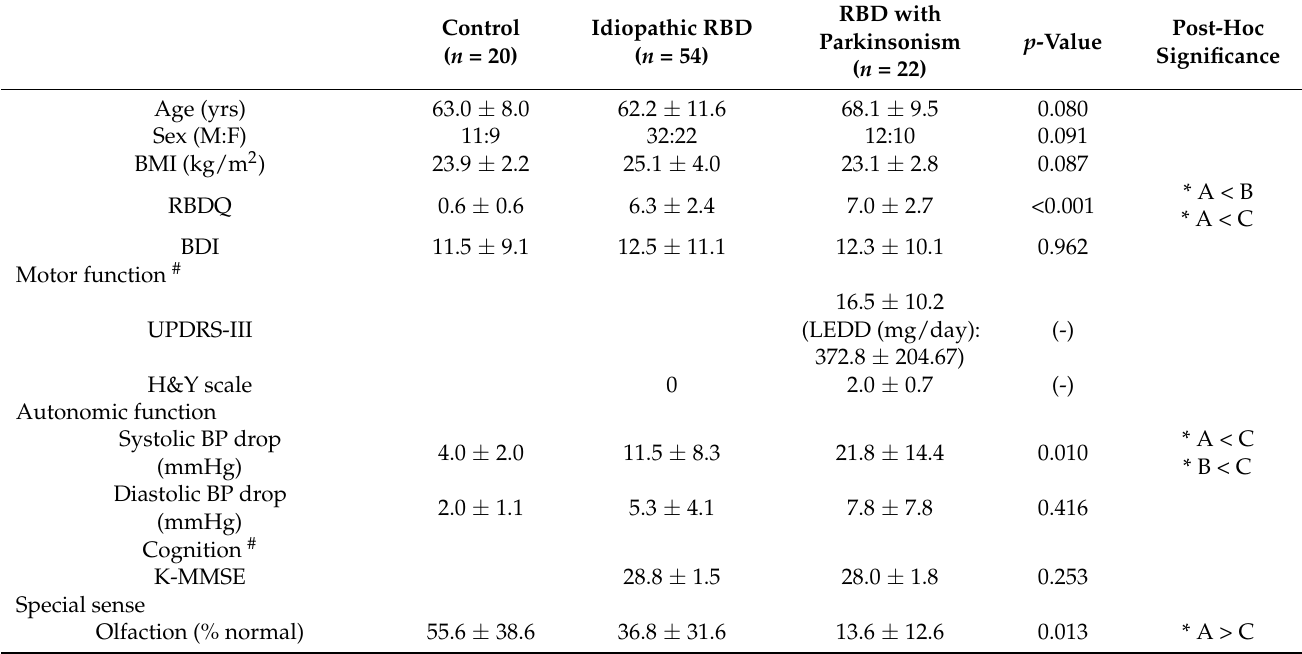
Table 1. Demographic findings and clinical features in control, patient groups with idiopathic RBD and patients with combined RBD and Parkinsonism.